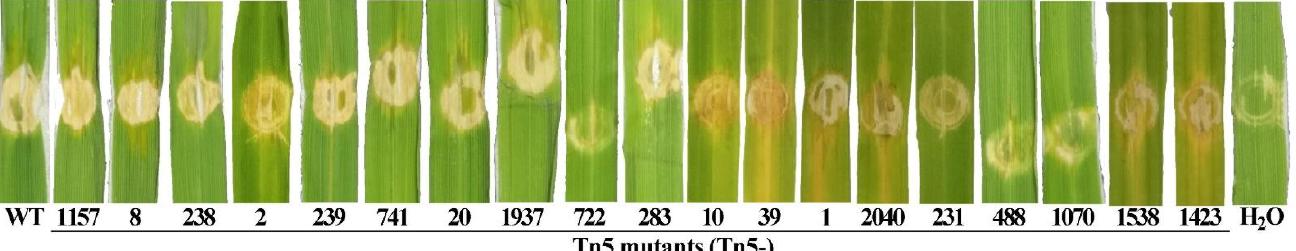
Figure 5. Effect of Tn5 insertion mutation on bacterial pathogenicity to rice were determined by infiltration inoculation of 19 Tn5 mutants representative of different genes on rice leaves. WT: Wild type strain C2; H 2 O: Negative control.